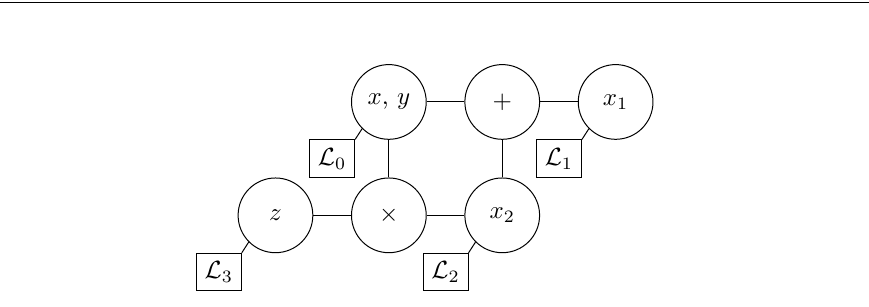
Figure 1: Factor graph with six nodes. L labels indicate intrinsic